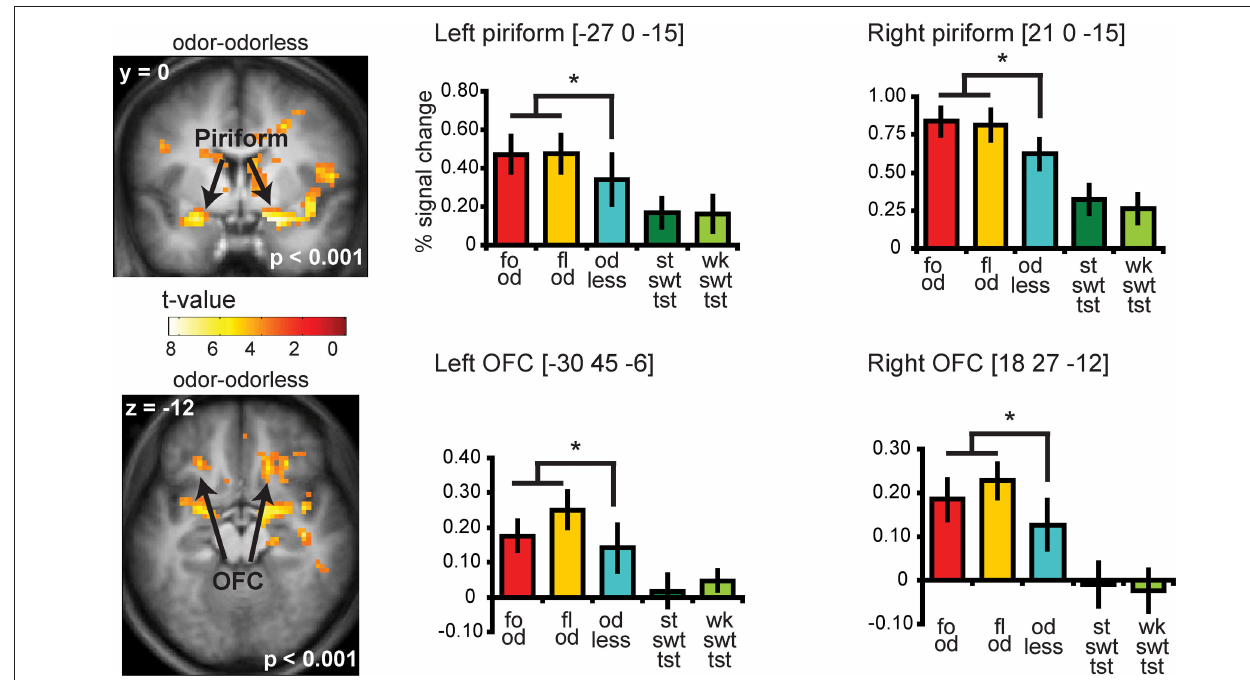
identified in the SPM analysis. Thus, these estimates are non-independent, and are provided to illustrate the relative difference in neural response. For illustrative purposes we also plotted the percent signal change for the strong sweet taste (st swt tst, dark green) and the weak sweet taste (wk swt tst, light green), which do not show a differential response in piriform and OFC.